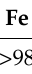
Table 2. Key characteristics of the zero-valent iron. Fe C Mn Si S >98 0.24 0.30 0.11